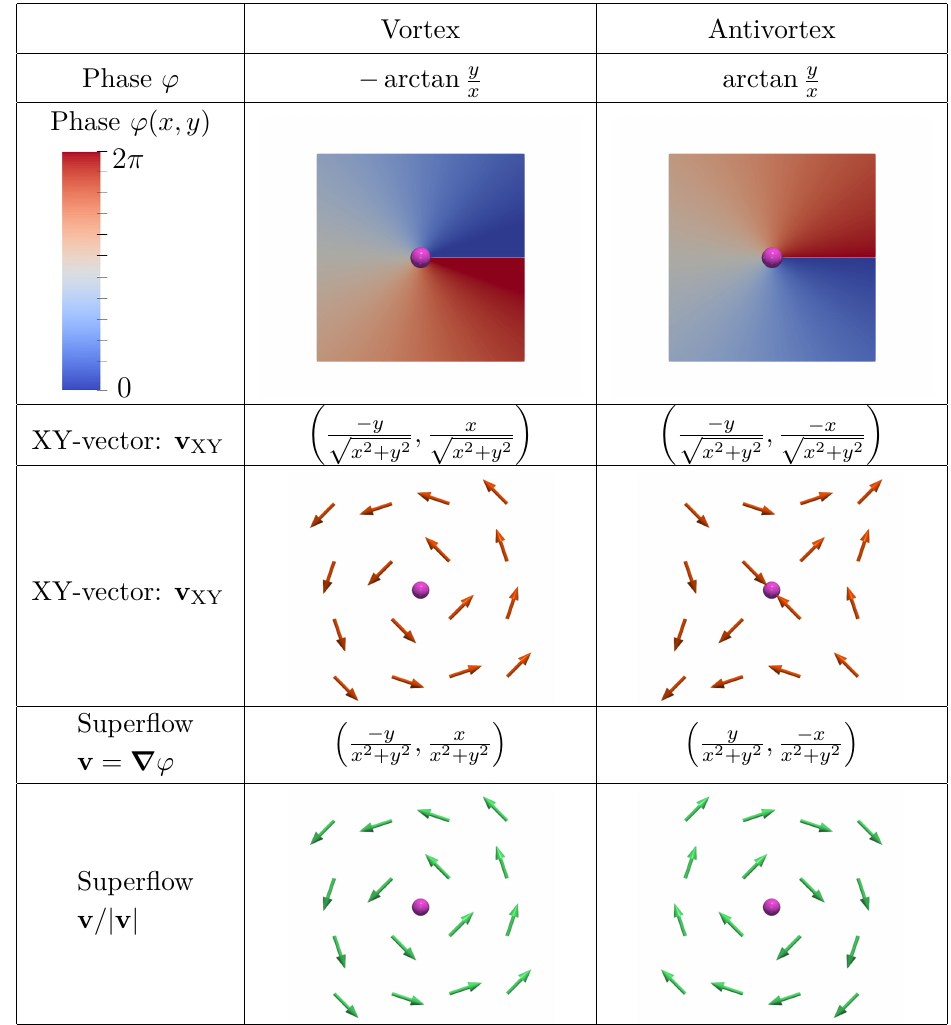
Table 1 . The table compares the vector fields v XY eq. (A.1) and v eq. (2.1) in the case of a vortex and an antivortex, corresponding to a fixed point of the XY-vector v XY and the velocity vector field v of the superflow. The red dot is the phase singularity. The vortex and the antivortex is respectively a center and a saddle, of the XY-vector field v XY . On the other hand, they are both centers of the vector field v